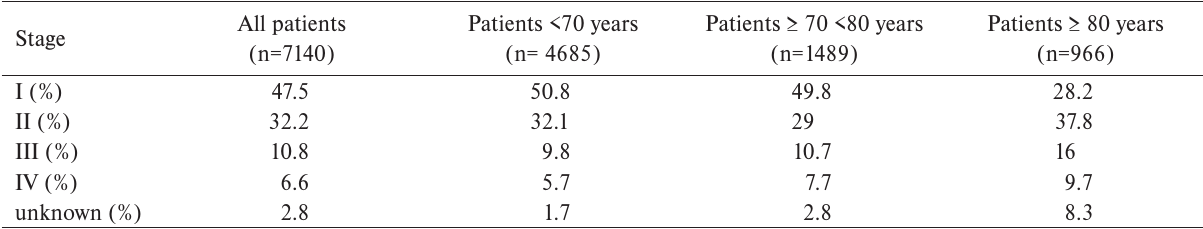
Table 1. Proportion of TNM stages at diagnosis for patients diagnosed with breast cancer in 2013 according to the Czech Cancer Registry 1 .